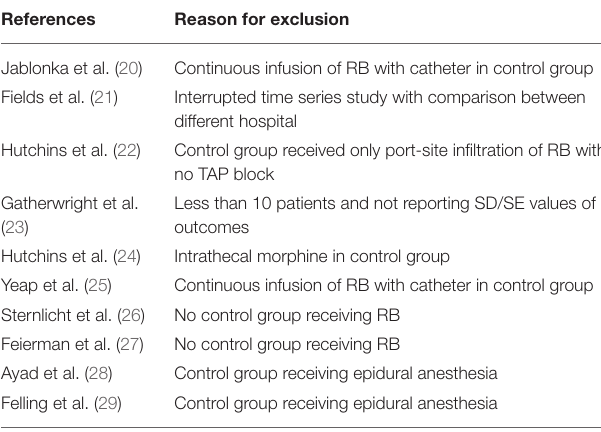
TABLE 1 | List of excluded